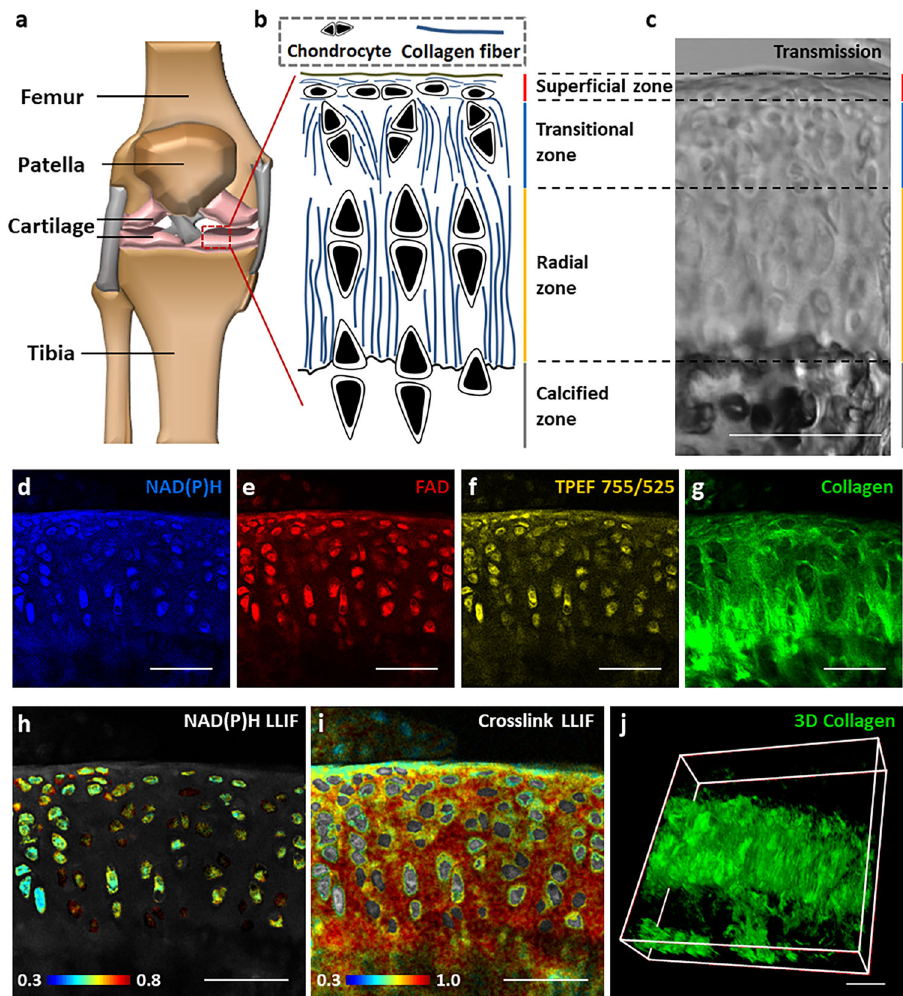
Fig. 1 An overview of articular cartilage organization and different types of endogenous contrast for TPEF and SHG imaging. a Schematic (generated using Microsoft PowerPoint) showing the structure of bone, with the location of articular cartilage marked. b Schematic showing the composition of cartilage, which can be distinguished into four different zones: super fi cial, transitional, radial and calci fi ed zone. c A representative transmission image from a mouse knee cryosection showing the segmentation of these four zones. Representative d NAD(P)H (755 nm ex./460 ± 20 nm em.), e FAD (860 nm ex./ 525±25 nm em.), f TPEF signal at 755 nm ex./525 nm em., g SHG image (920 nm ex./460 ± 20 nm em.), h NAD(P)H LLIF-coded image, and i cross-link LLIF-coded image from the same fi eld. j A representative 3D SHG image stack used for the assessment of collagen fi ber organization in a 3D context. Scale bar: 50 μ